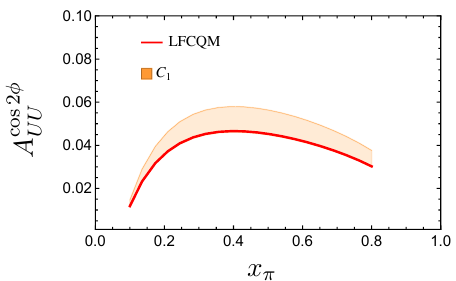
x (cid:25) Figure 10 . A cos2 (cid:30) as a function of x (cid:25) , the orange region corresponds to variation of C 1 in the UU interval [ e (cid:0) (cid:13) E ; 4 e (cid:0) (cid:13) E ] and illustrates the sensitivity of our results to scale